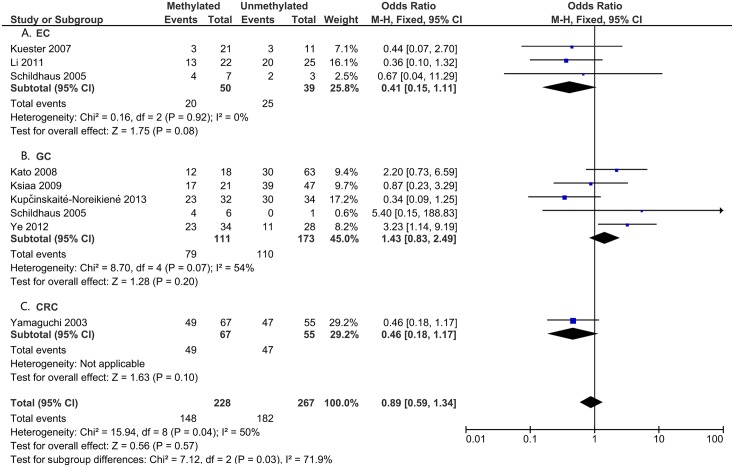
DAPK1 methylation and T stage (T3+T4 vs.T1+T2) in: A. EC; B. GC; and C. CRC.